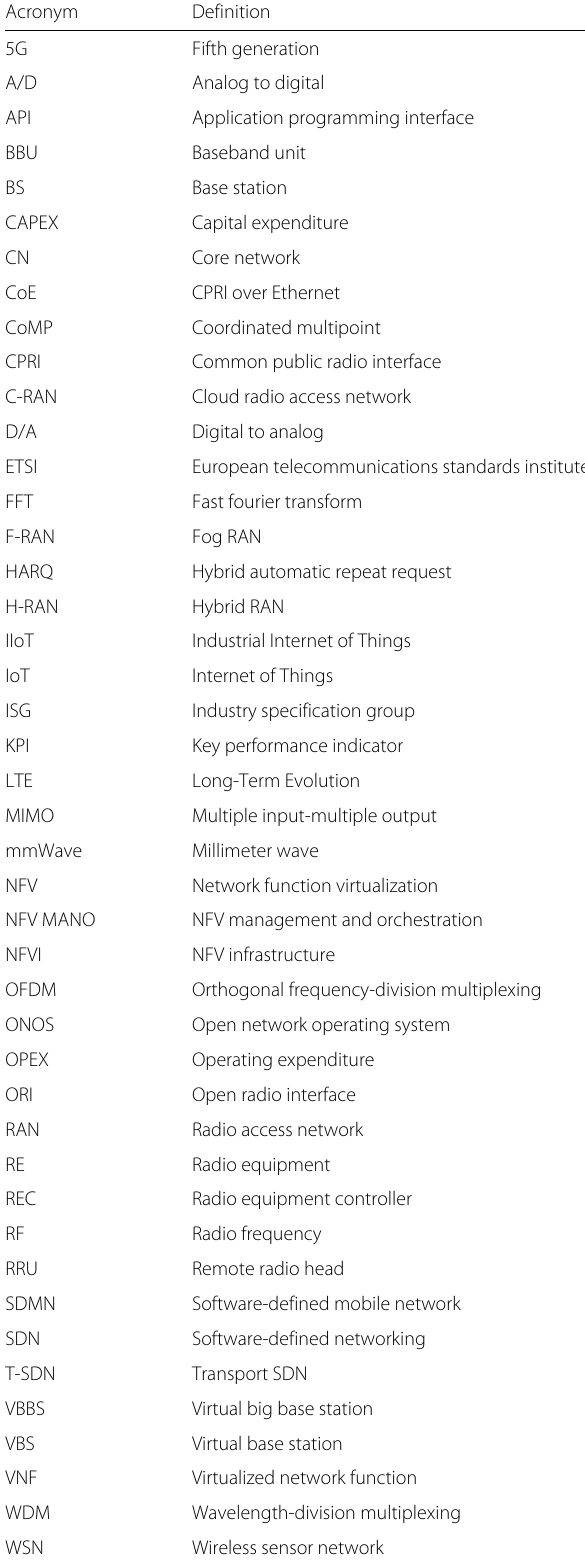
Table 1 List of